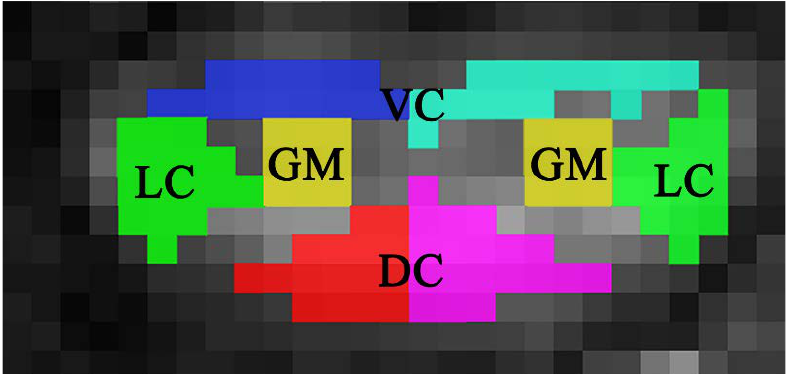
Figure 1. ROIs covering the whole spinal cord.